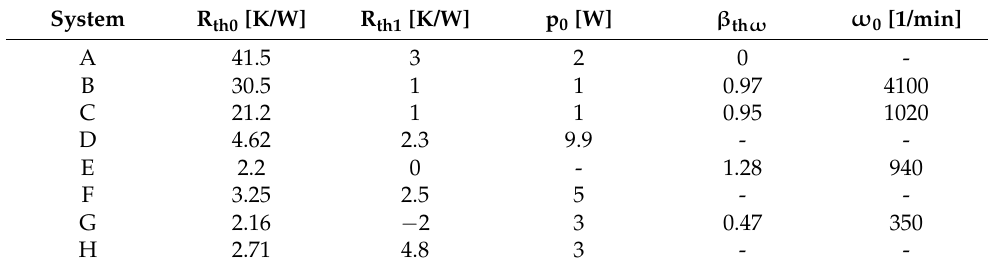
Table 1. Values of R th (p, ω ) model parameters for the tested cooling systems.